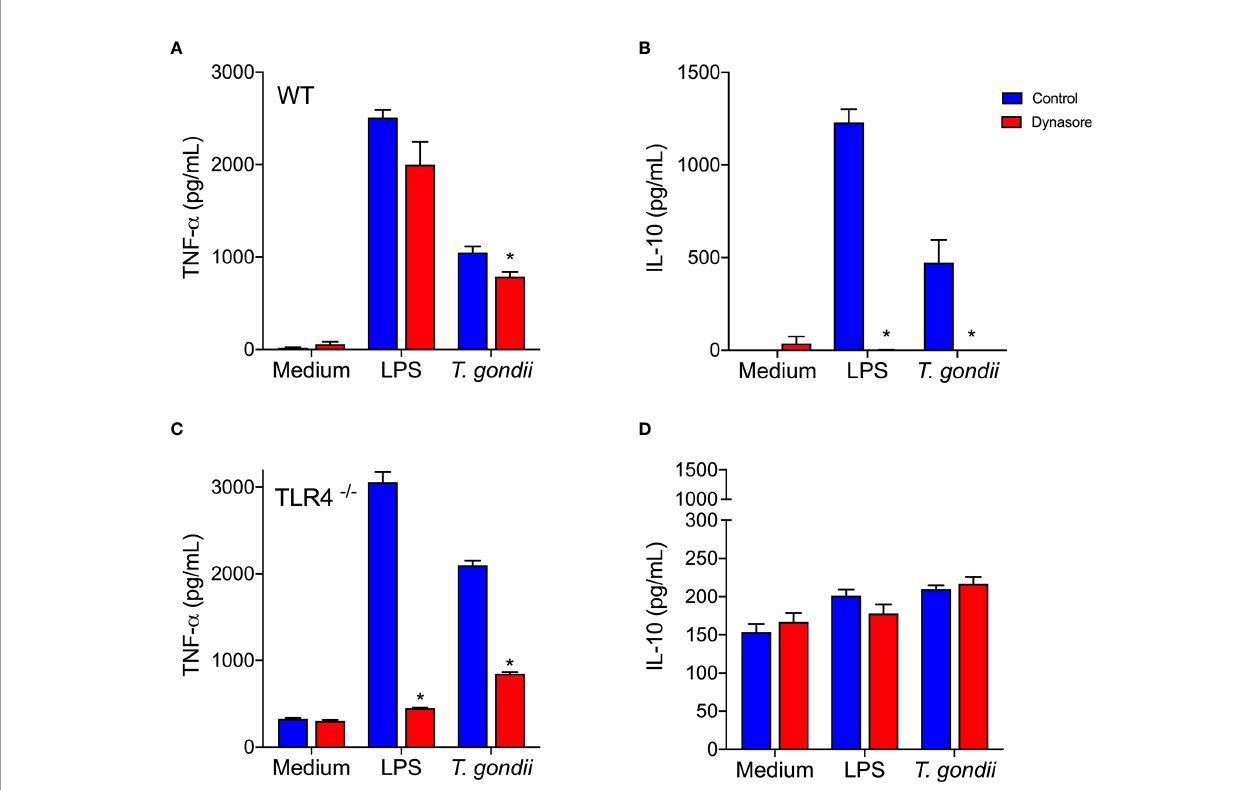
FIGURE 4 | Toxoplasma gondii -infected BMDMs produce IL-10 via a TLR4 and endocytosis dependent mechanism. WT (A, B) and TLR4 -/- (C, D) BMDMs were pretreated (red bars) or not (control - blue bars) with Dynasore, then stimulated with Medium only or LPS, or infected with T. gondii (at a ratio of 3 parasites/BMDM). After 24 h, cell supernatants were analyzed for TNF- a (A, C) and IL-10 (B, D) levels. Results are expressed as averages + SD of two independent experiments, each performed in triplicate. Two-way ANOVA followed by Tukey ’ s test was performed (* = p < 0.05 in comparison with control under same